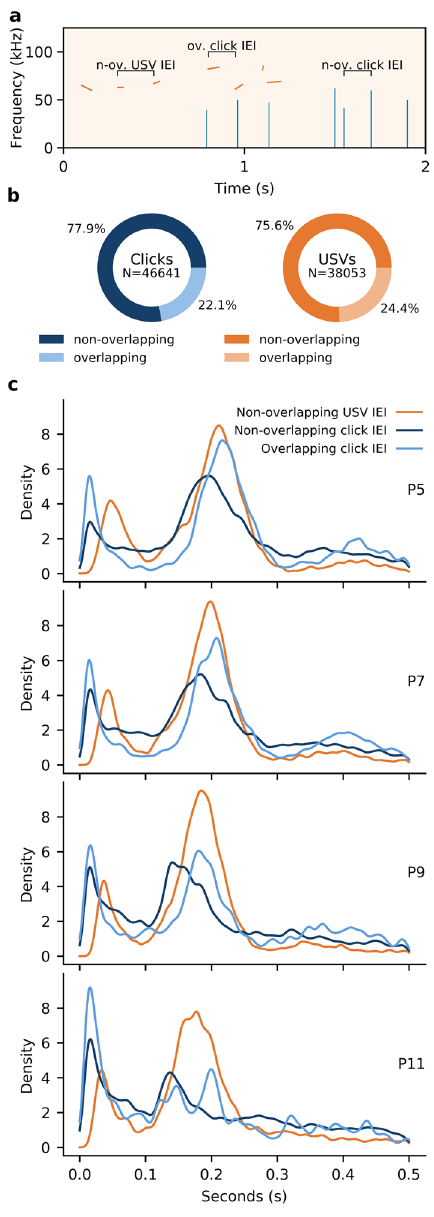
Figure 4. Inter-event intervals for USVs and clicks show a clear bimodal distribution. ( a ) Schematic showing the different click and USV combinations analysed here. USVs (orange) either occur alone (left grouping), or in conjunction with a click (middle grouping). Similarly, clicks either occur in conjunction with a USV (middle) or alone (right). Inter-event intervals (IEI) were calculated as shown. ( b ) Left: Of the approximately 46 thousand clicks analysed from wild type animals, 22.1% co-occurred with a USV. Right: similarly, 24.4% of the 38 thousand USVs recorded from wild type animals co-occurred with a click. ( c ) Kernel density estimation (KDE) of the non-overlapping USV IEIs show a bimodal distribution, with the first peak indicating vocalizations uttered within the same respiration, and the second peak indicating vocalizations uttered in consecutive respirations. Similarly, clicks co-occurring with USVs show a similar patterning, with a bimodal distribution indicating within-respiration and within-bout